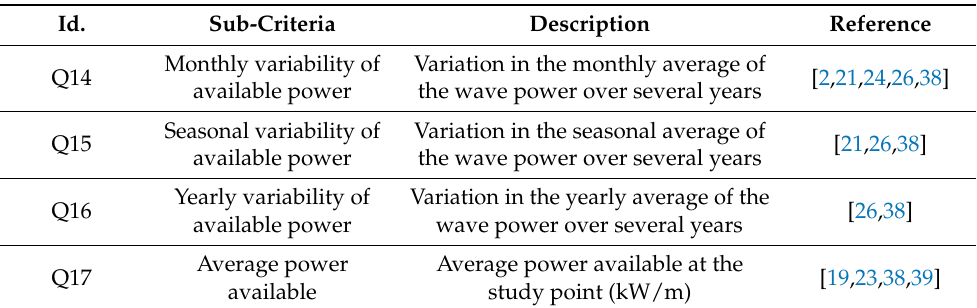
Area 2: Conditions associated with the energy harvesting technology. Table A4. Block 3: Influence of the available wave resource and its variability on a wave energy project. Q14 to